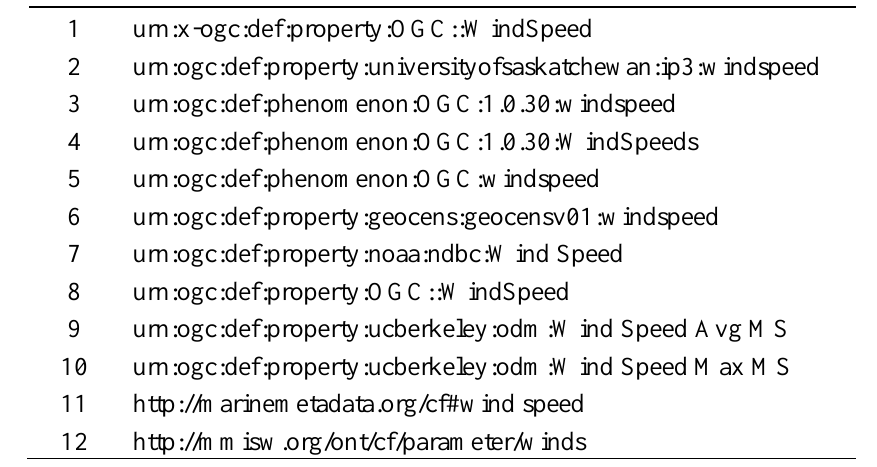
Table 1. Various URIs of the concept of wind